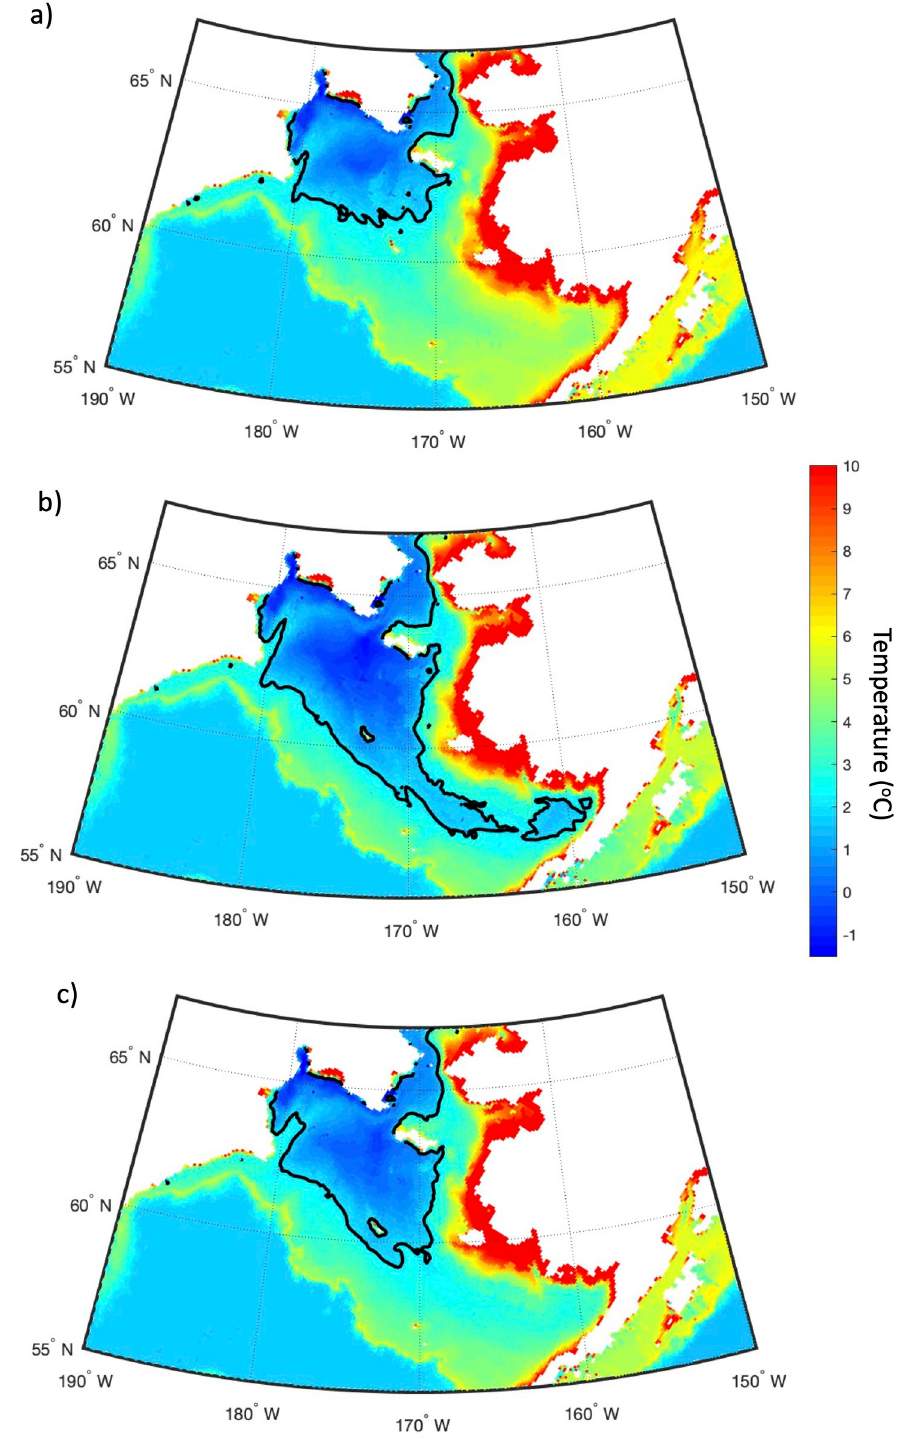
Fig 18. Predicted bottom water temperature for July 15, 2019, 2020 and 2021. Bottom water temperature (˚C) on July 15, 2019 (a), 2020 (b) and 2021 (c), as predicted by the RASM ensemble forecast initialized on February 1, 2019 (a), 2020 (b) and 2021 (c). The black contour line indicates the position of the 2˚C isotherm. Figure created using Matlab (v. 2018a) from the authors’ data.